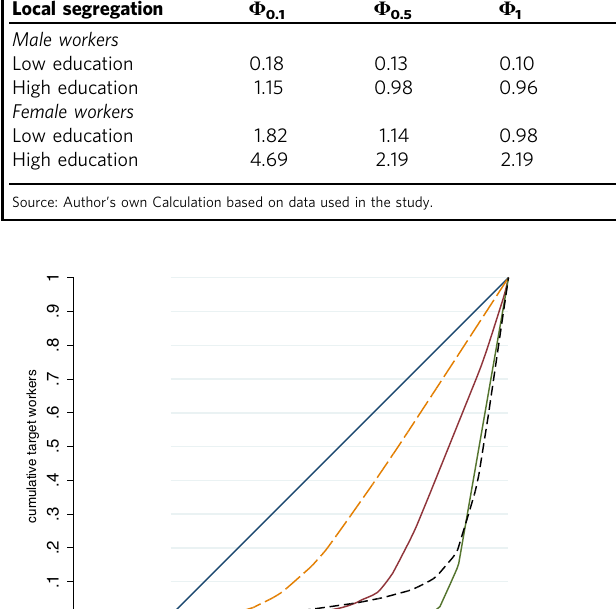
Table 7 Occupational gender segregation by level of education. Local segregation